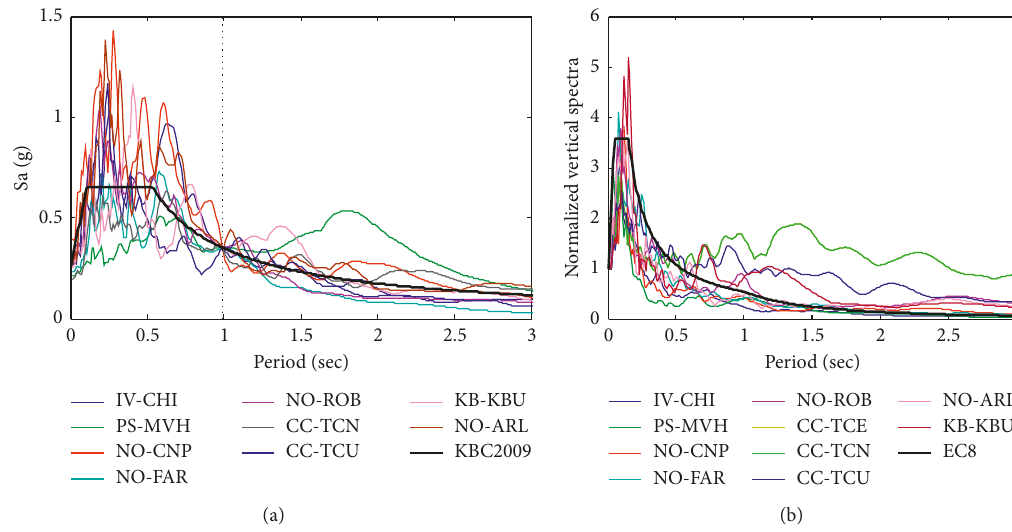
Figure 4: Response spectra of the selected records: (a) horizontal spectra, and (b) normalized vertical spectra.